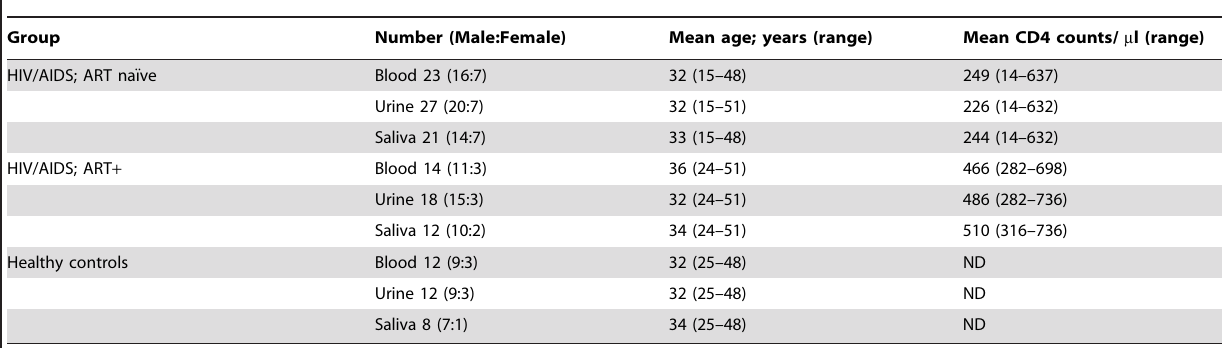
Table 1. Details of clinical